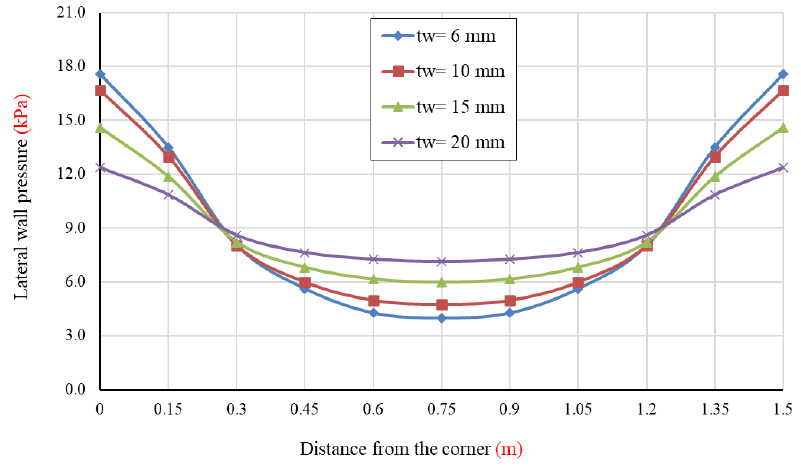
Figure 17. Effect of wall thickness on lateral wall pressure.